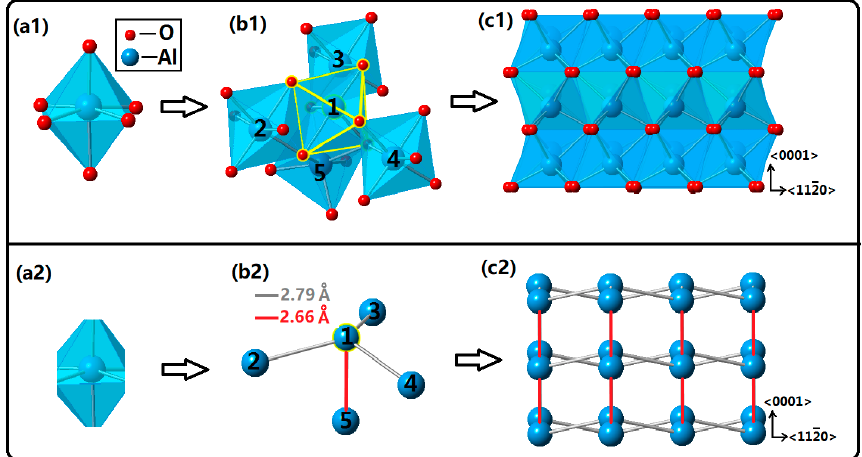
Figure 6. The schematic diagram of the simplified sapphire atomic structure: ( a1 ) one octahedron includes one Al and six O atoms; ( b1 ) the co-plane and co-edge ways of octahedrons; ( c1 ) the non- simplified sapphire atomic structure; ( a2 ) the octahedron that has been simplified (ignoring O atoms); ( b2 ) the grey and red connections between Al atoms that correspond to the co-edge and co-plane ways between octahedrons; ( c2 ) the sapphire atomic structure that has been simplified.